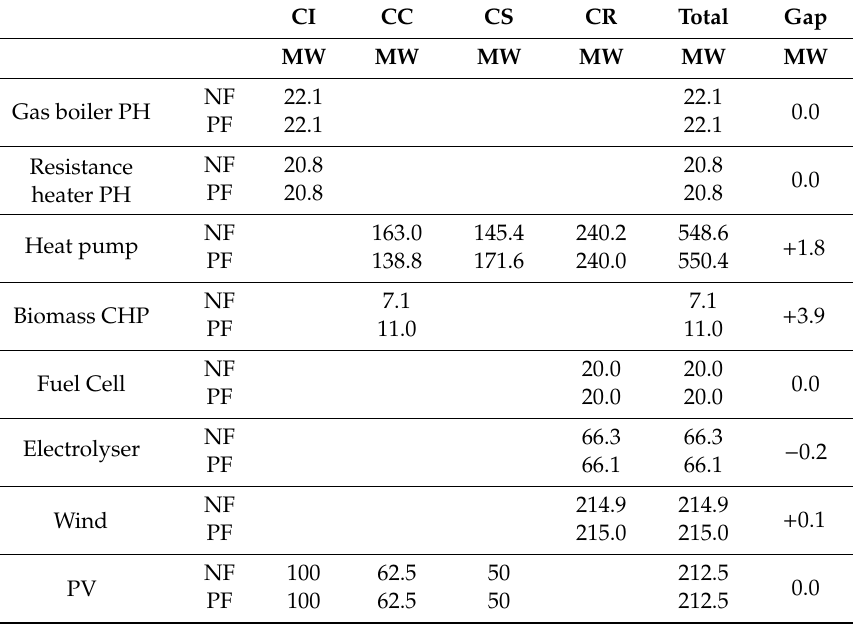
and RES capacities P R c , inst